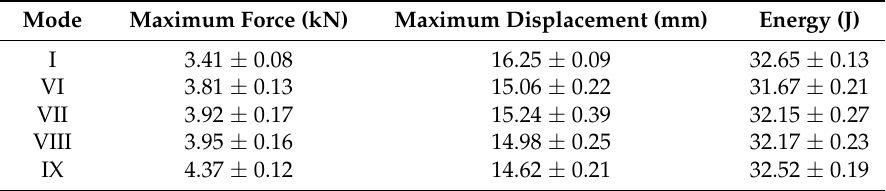
Table 4. Impact responses of the sandwich panels without or with two layers of SMA